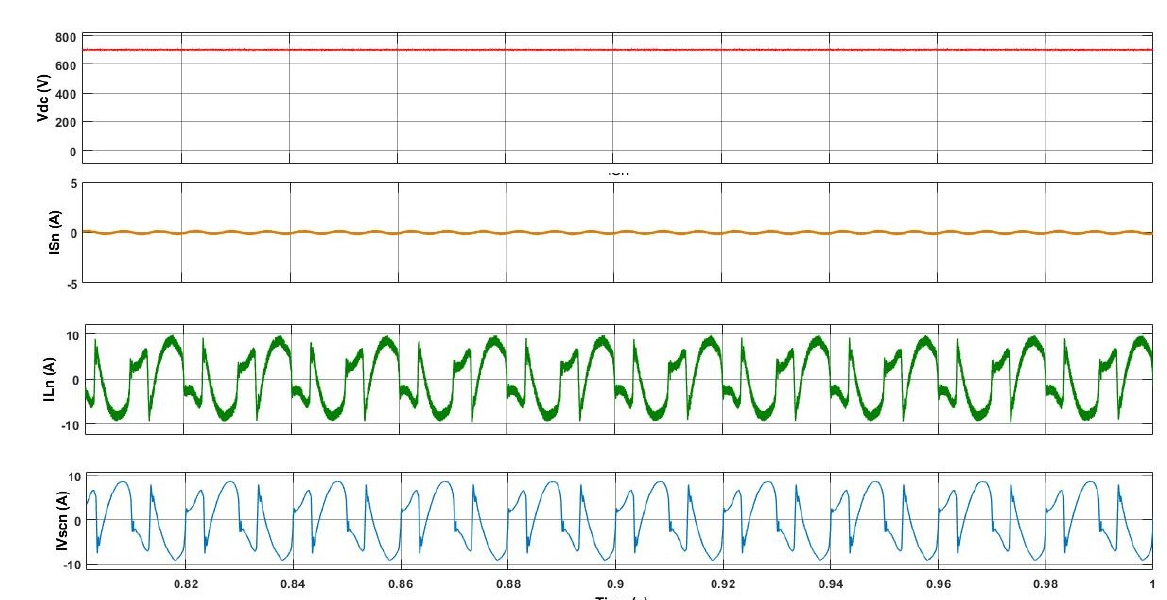
Figure 9. Vdc: DC link voltage, ISn: input neutral current, ILn: load neutral current, and IVscn: compensator neutral current.